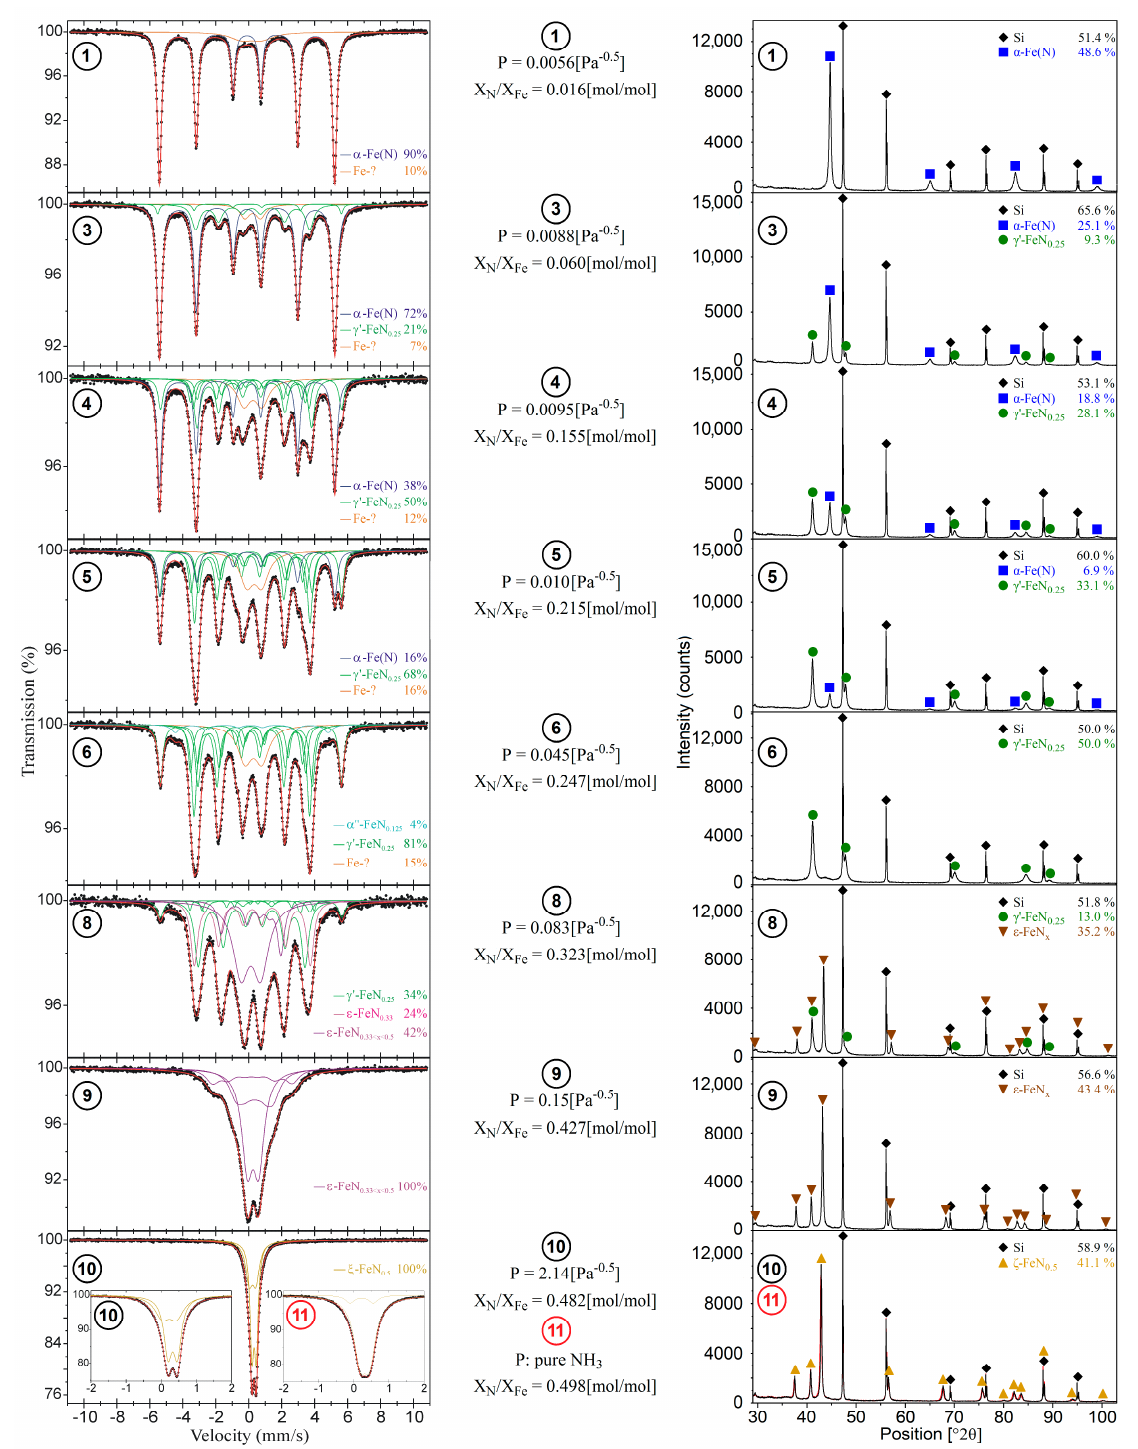
Figure 1. The comparison of 57 Fe Mössbauer spectra and X-ray di ff ractograms for selected samples obtained in the nitriding process of nanocrystalline